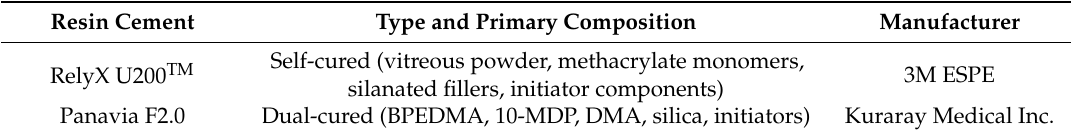
Table 2. Resin cements used in the present